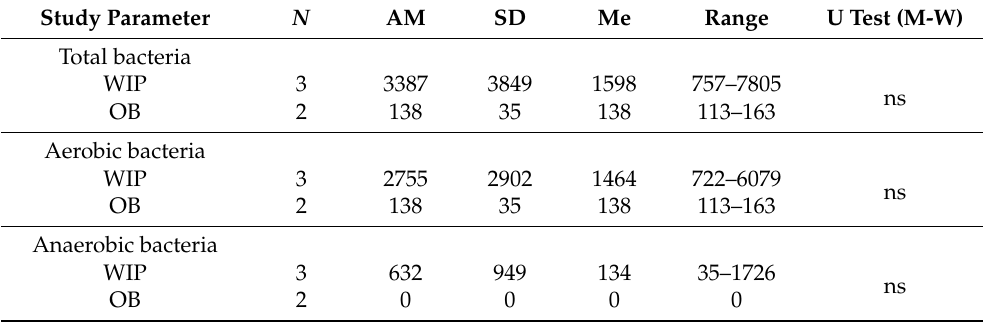
Table 3. Bacterial aerosol concentrations (CFU/m 3 ) in worksites under